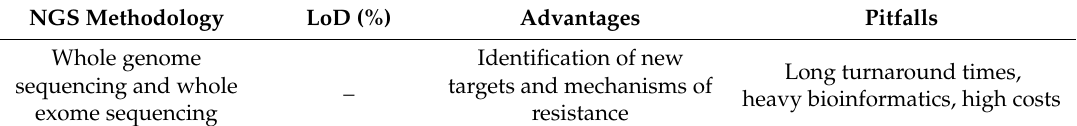
Table 2. Characteristics of the main NGS methodologies used for liquid biopsy